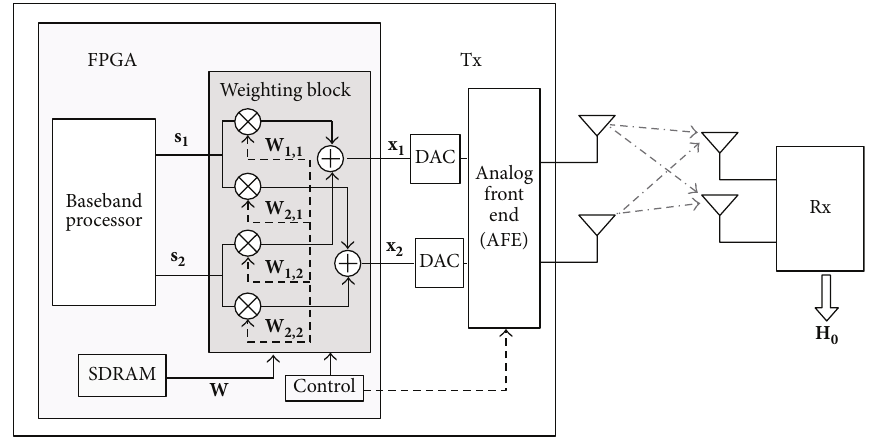
Figure 2: Scheme for 2 × 2 MIMO OTA testing and channel emulation.